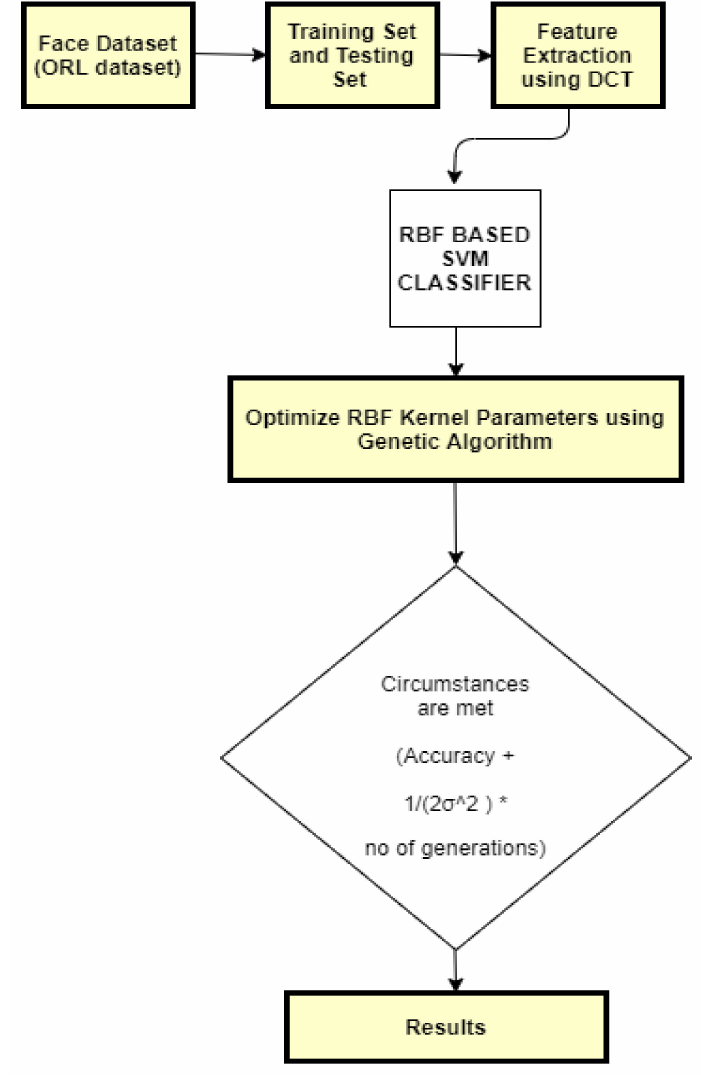
Figure 3. Proposed model.